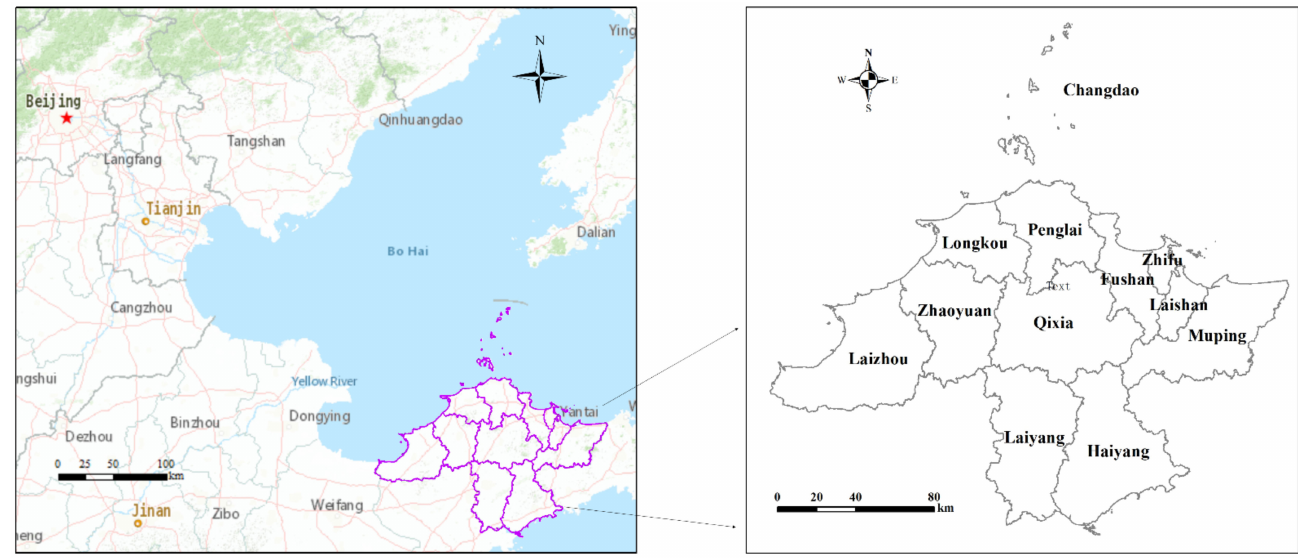
Figure 1. Location of study